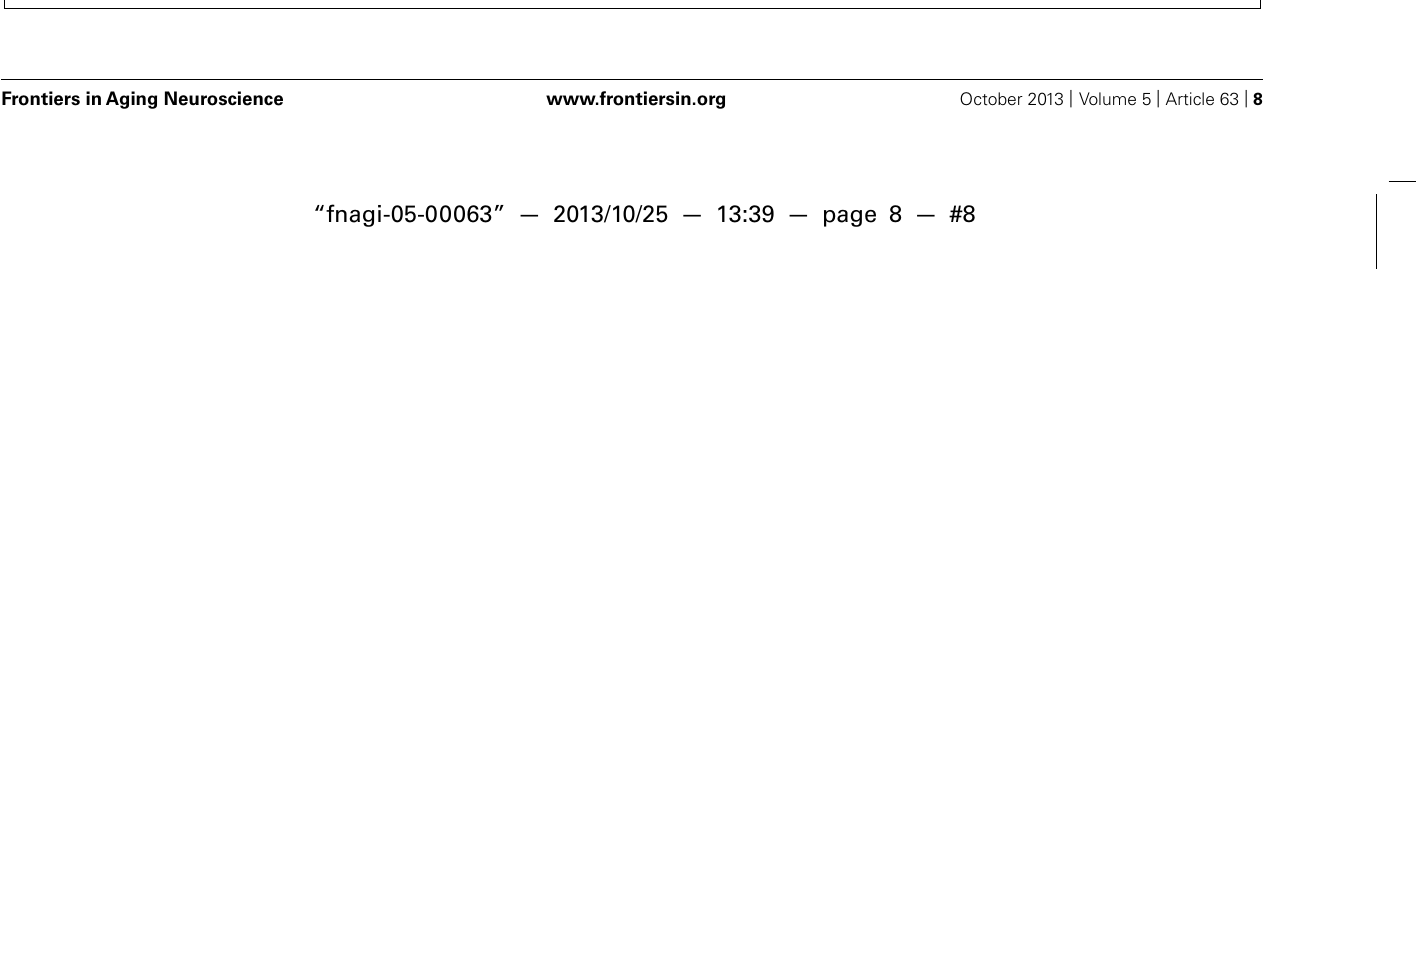
FIGURE 3 | Regions with significant correlation between memory performance evaluated with the BabcockTest and cortical thickness measure in the High a3/a2 group. r and p denote the correlation coefficient and significance level